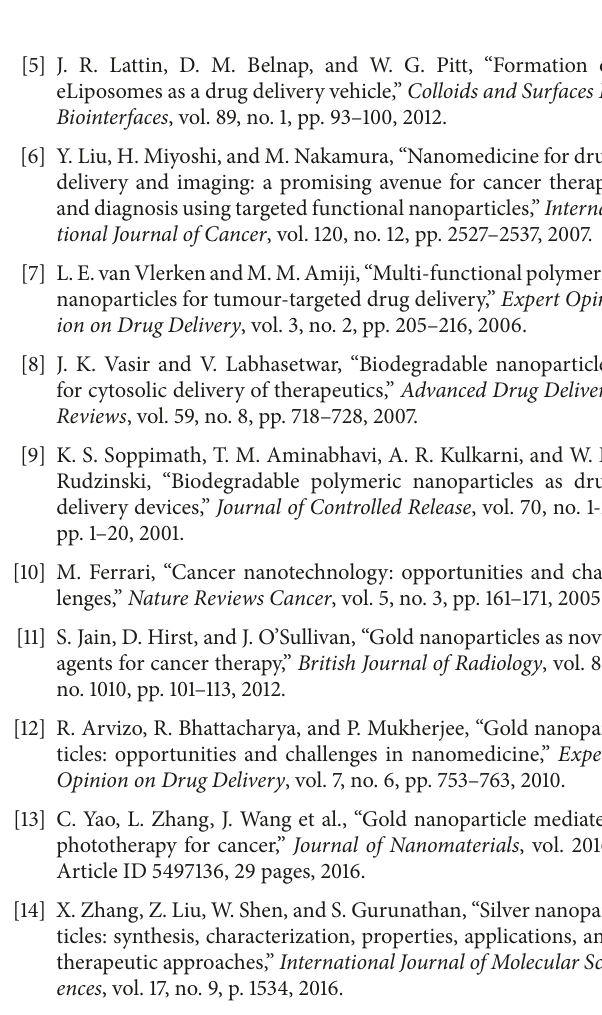
Figure 9: Viability of the U-937 cells (a) and K-562 cells (b) after cultivation with the nanoparticles at different concentrations for 48 h measured by MTT assay (a) and Trypan Blue assay (b). Mean values of triplicates with standard deviation are shown. ∗ 𝑃 < 0.05 compared to the untreated